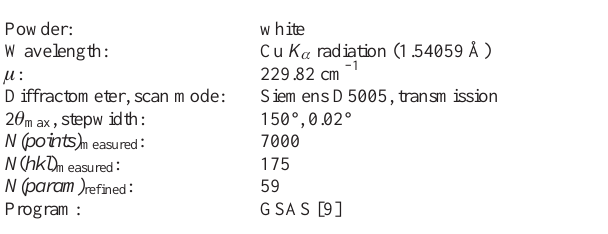
Table 1. Data collection and